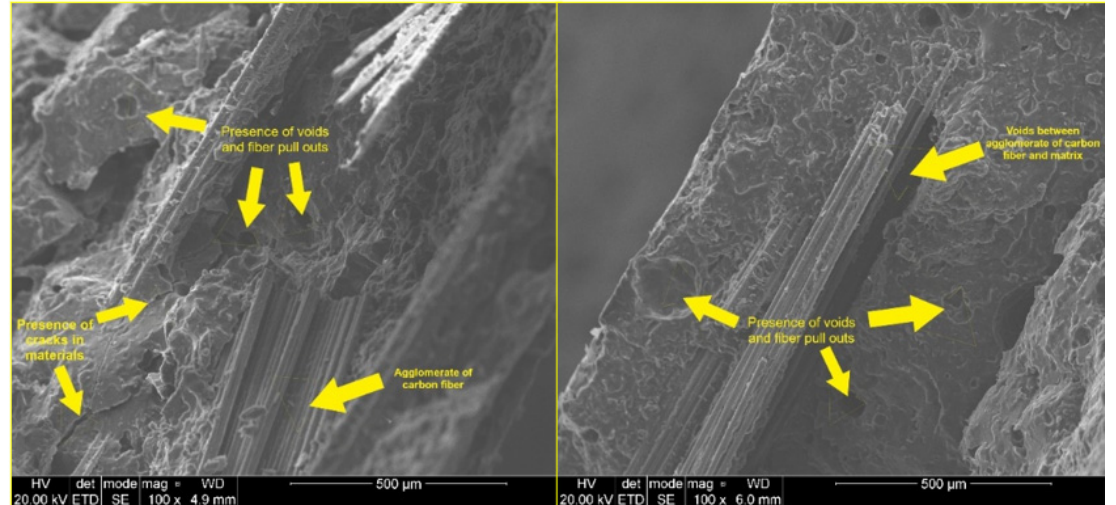
Figure 9. SEM images of the sample coded 50% CF.